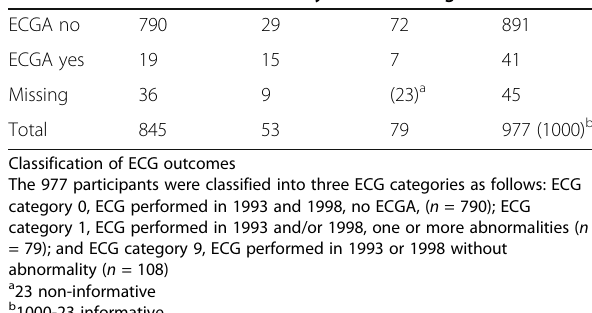
Table 2 Electrocardiographic abnormalities (ECGA) of the 977 cohort participants, men aged 45 – 50, in 1993 (baseline) and at follow up in 1998